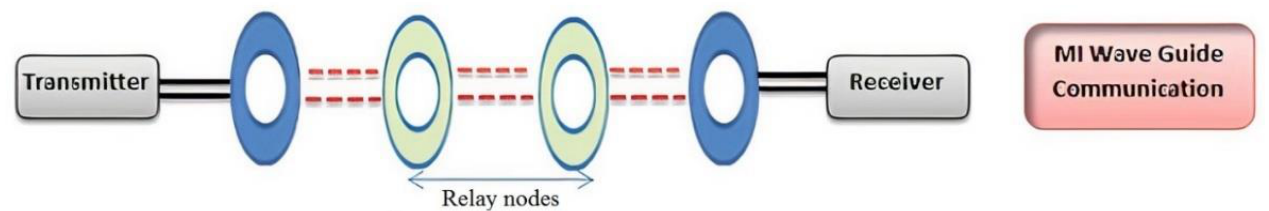
Figure 4. Structure of MI waveguide technique.